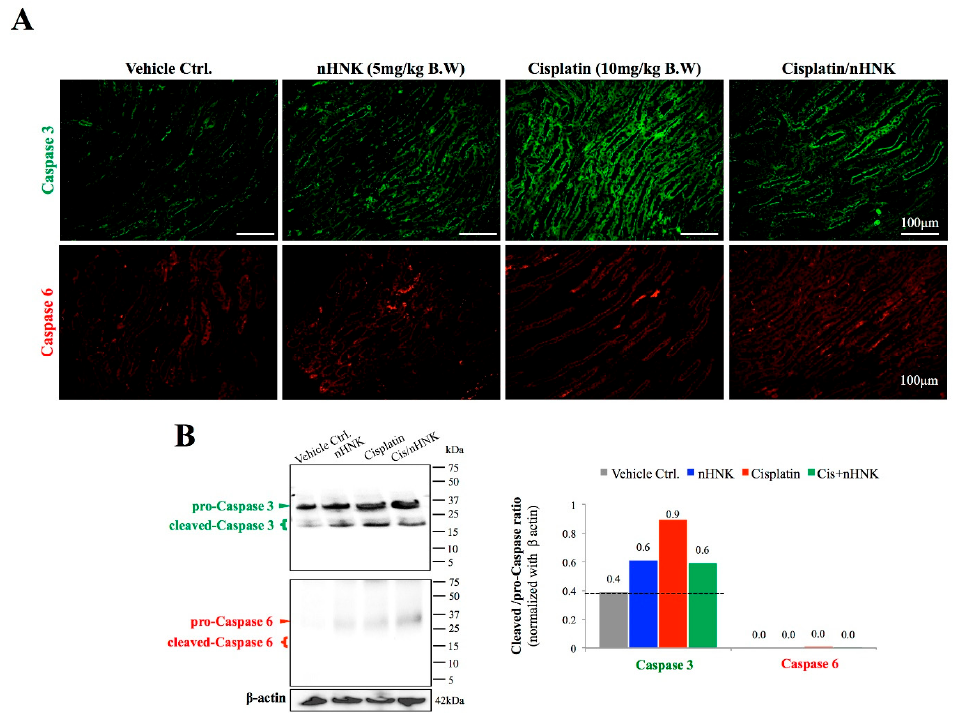
Figure 5. Evaluation of caspase-dependent signaling pathway in cisplatin-injured animals. Caspase 3